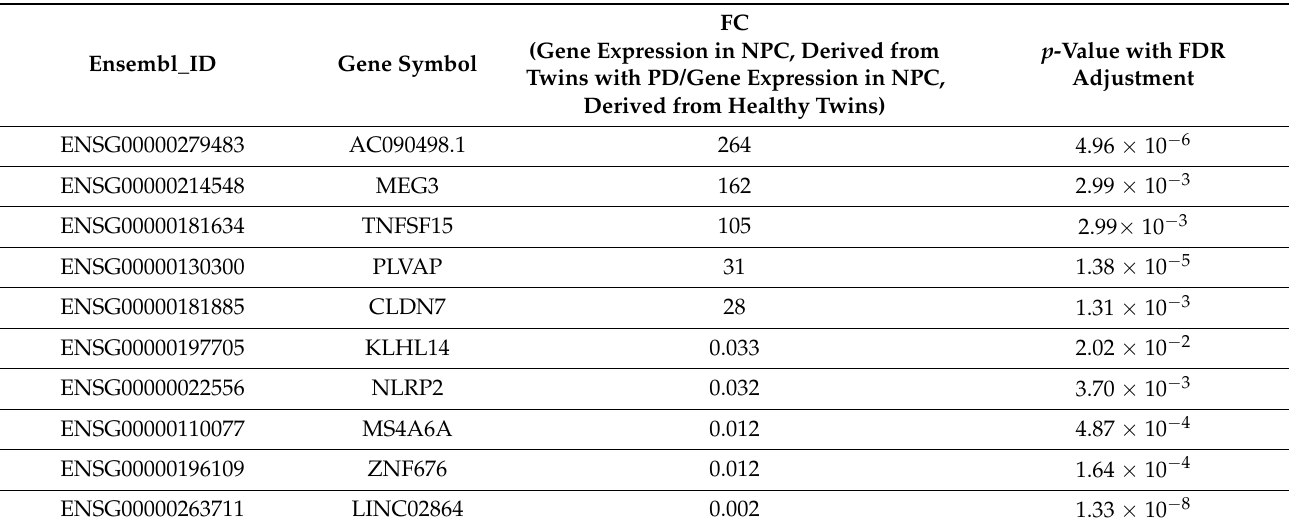
Table 2. Top 5 DEGs up- and down-regulated by fold change in NPC.